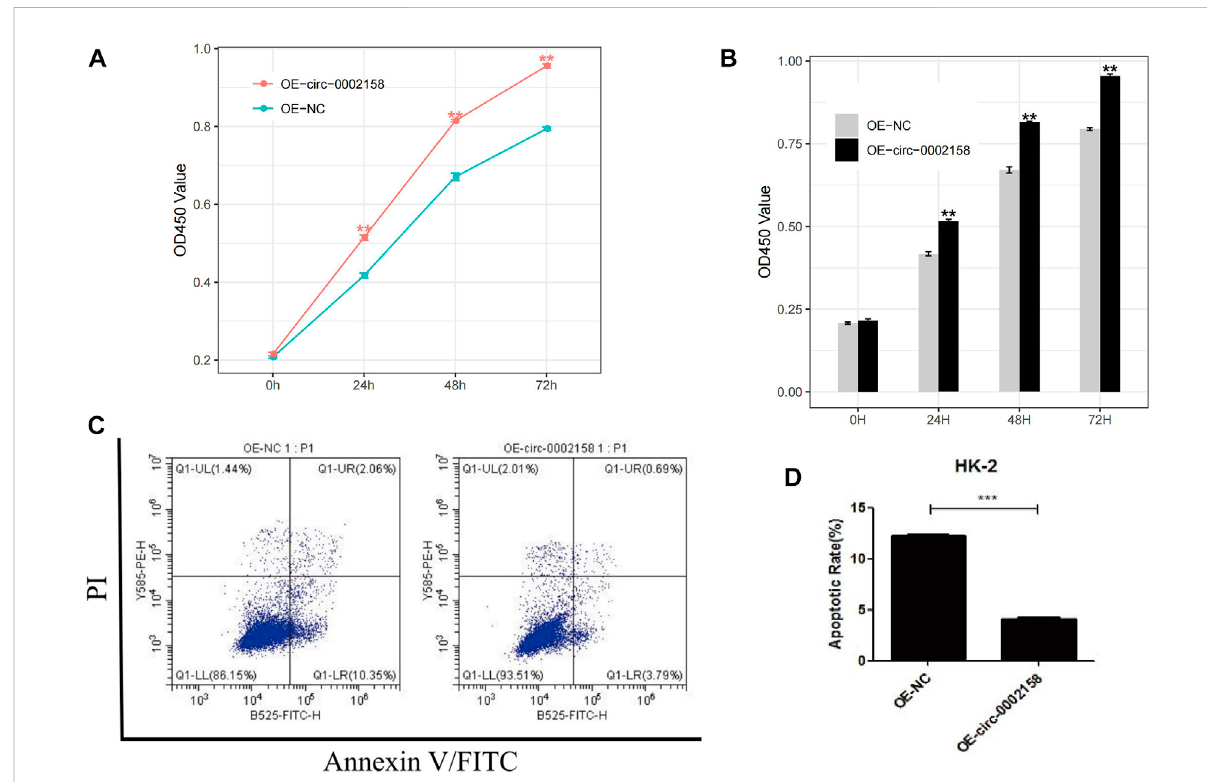
FIGURE 4 Circ_0002158 regulating the proliferation and apoptosis of HK-2 cells. (A,B) Overexpression (OE) of circ_0002158 promoted proliferation of HK-2cellsat0,24,48and72 hasassessedusingMTTassay. (C,D) OEofcirc_0002158functionintheHK-2cellswasassessedusing fl owcytometry. Data have been represented as mean ± SD. * p < 0.05, ** p < 0.01, and *** p <